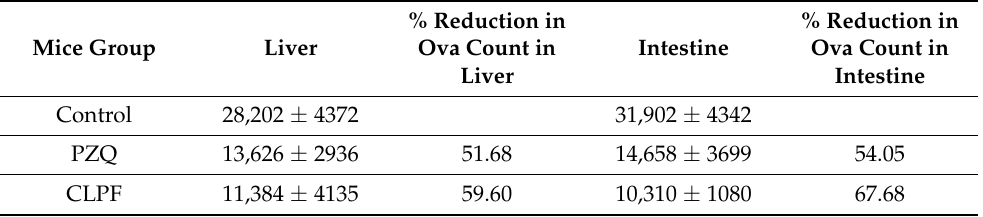
Table 6. Effect of PZQ and CLPF (single dose 250 mg/kg four weeks post-infection) on number of ova/gm tissues in S. mansoni -infected mice euthanized six weeks